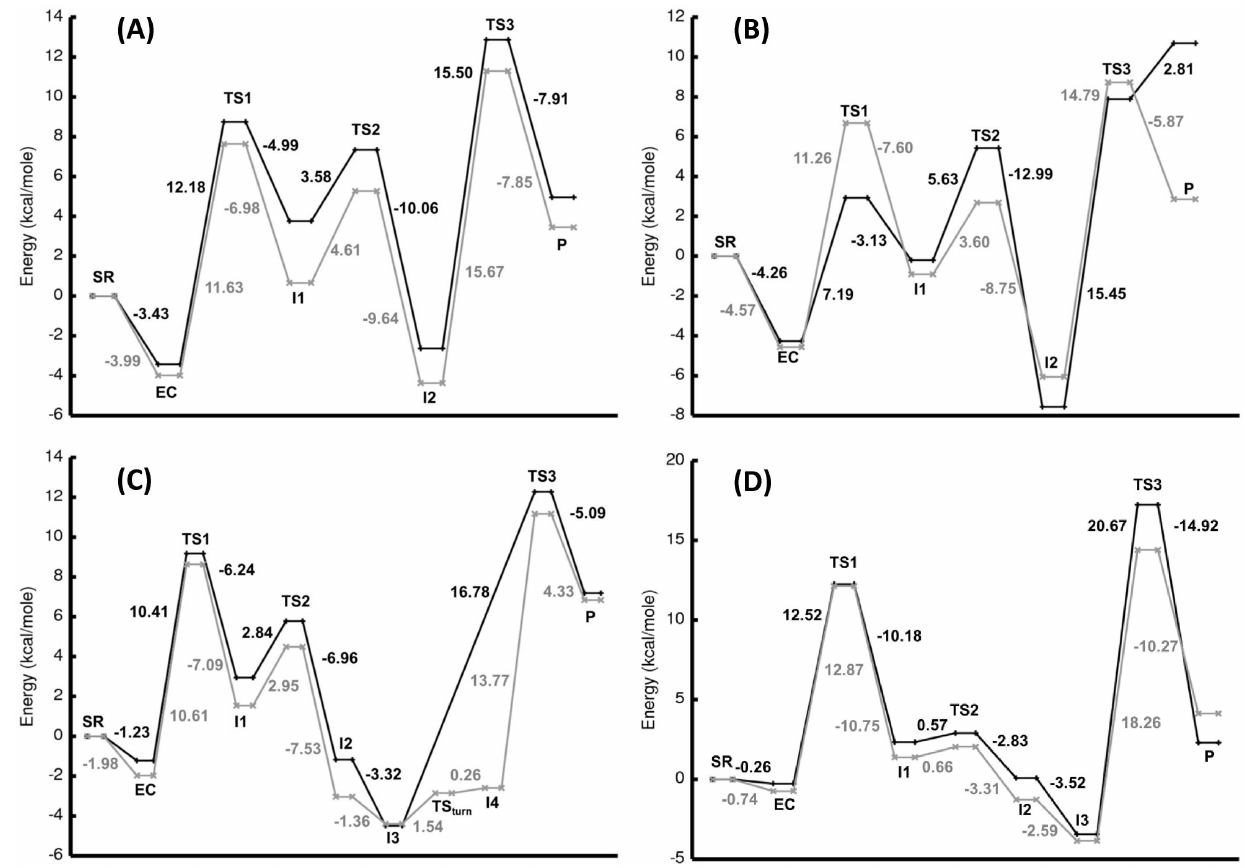
Figure 4. Relative energy of the calculated stationary points for N3 in Panel (A), N4 in Panel (B), Ph in Panel (C), and Ben in Panel (D) along the reaction coordinate relative to the separated reactants (SR). The energies for the zinc complexes are represented by the gray line and the cobalt complexes by the black line.